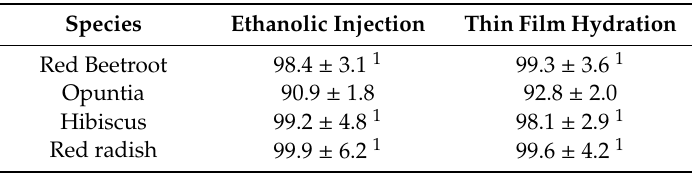
Table 3. Encapsulation efficiencies, EE (%) ± SD (%), of the several plant extracts in soybean lecithin liposomes, prepared by either by ethanolic injection or thin film hydration (SD: standard deviation).